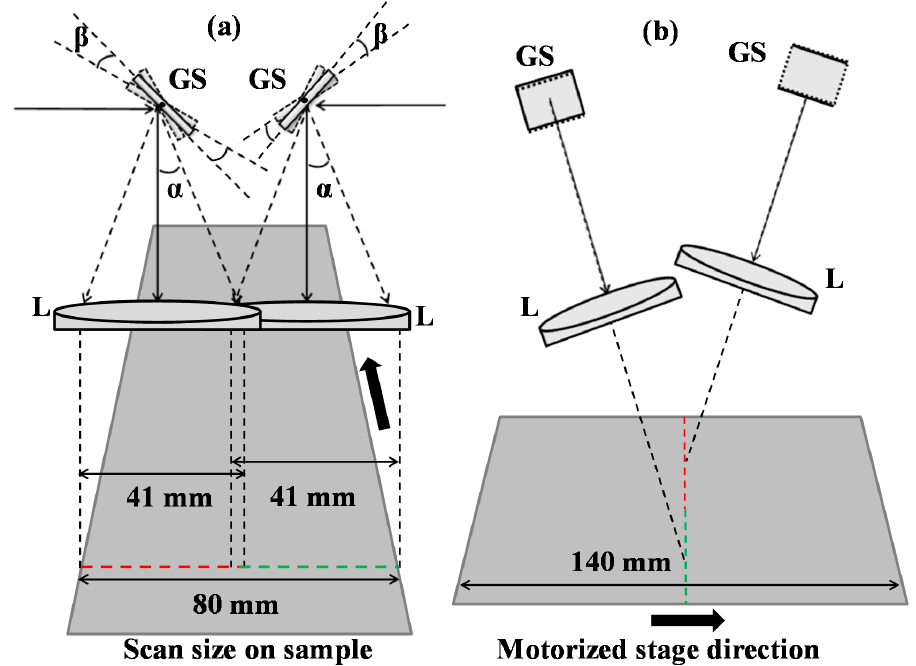
Figure 2. Schematic diagram of a two-sample-arm scanning head setup: ( a ) scan view in the x-direction; ( b ) scan view in the y-direction.